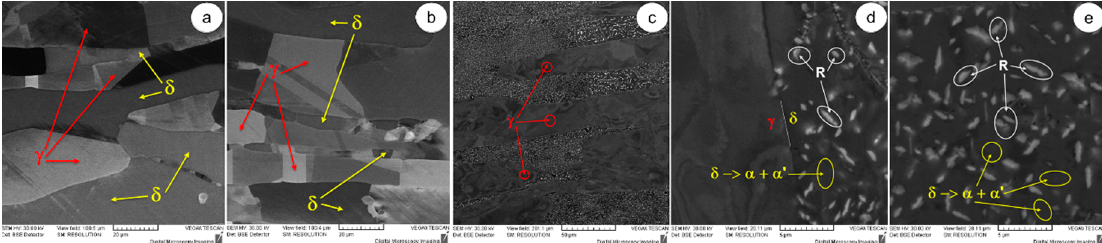
Figure 10. Scanning electron microscopy (SEM)-BSE images of long-duration aging treatment A1.2 ( a ), A2.2 ( b ), and A3.2 ( c ); high-magnification SEM-BSE images of A3.2 ( d ) and ( e ).